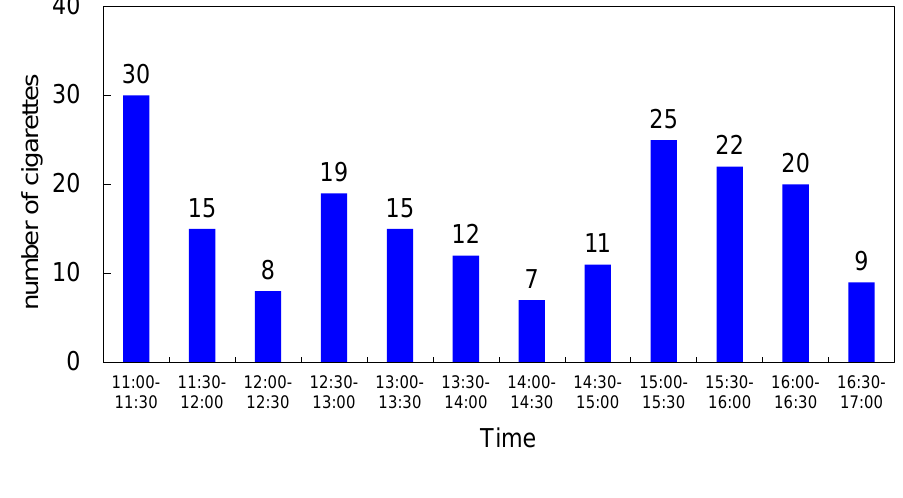
Figure 4. Summary of the number of cigarettes burned every 30 min during the working day (11:00–17:00, 1 May